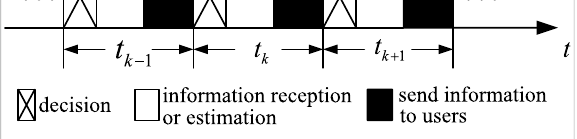
FIGURE 2 The actionsofthe edgenode ineachtime slotcan bedivided into three parts: making decisions, receiving sensor status updates or information estimation, and sending information to users. The action of receiving the users ’ requests is included in the decision-making